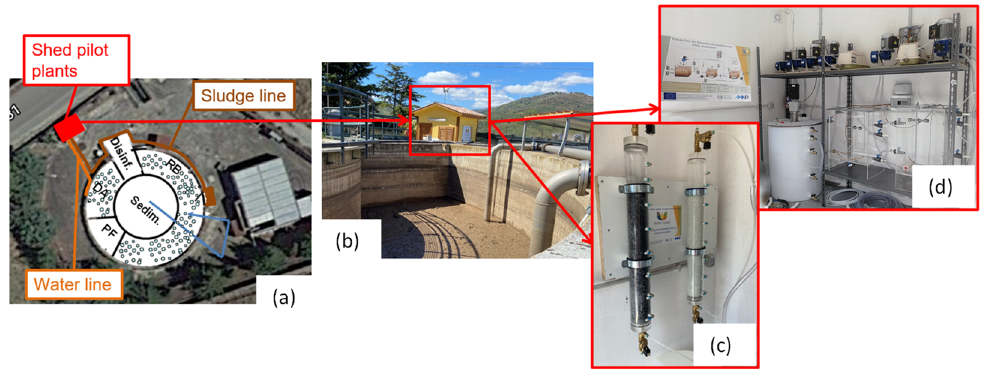
Figure 3. Modified orthophoto of the combined basin under study ( a ), particularly of the Wider- Uptake Shed ( b ), and the deviation lines for nutrient adsorption ( c ) and PHA production ( d ).